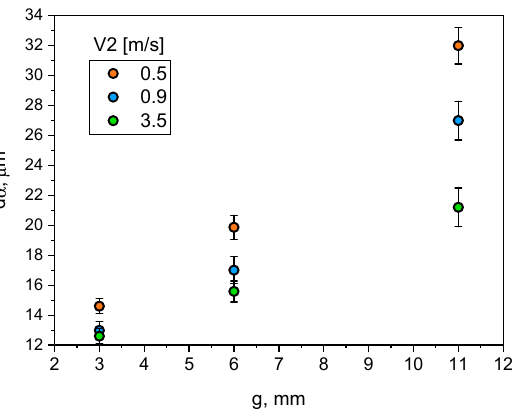
Figure 10. Influence of casting wall thickness and compression pressure on d α parameter.